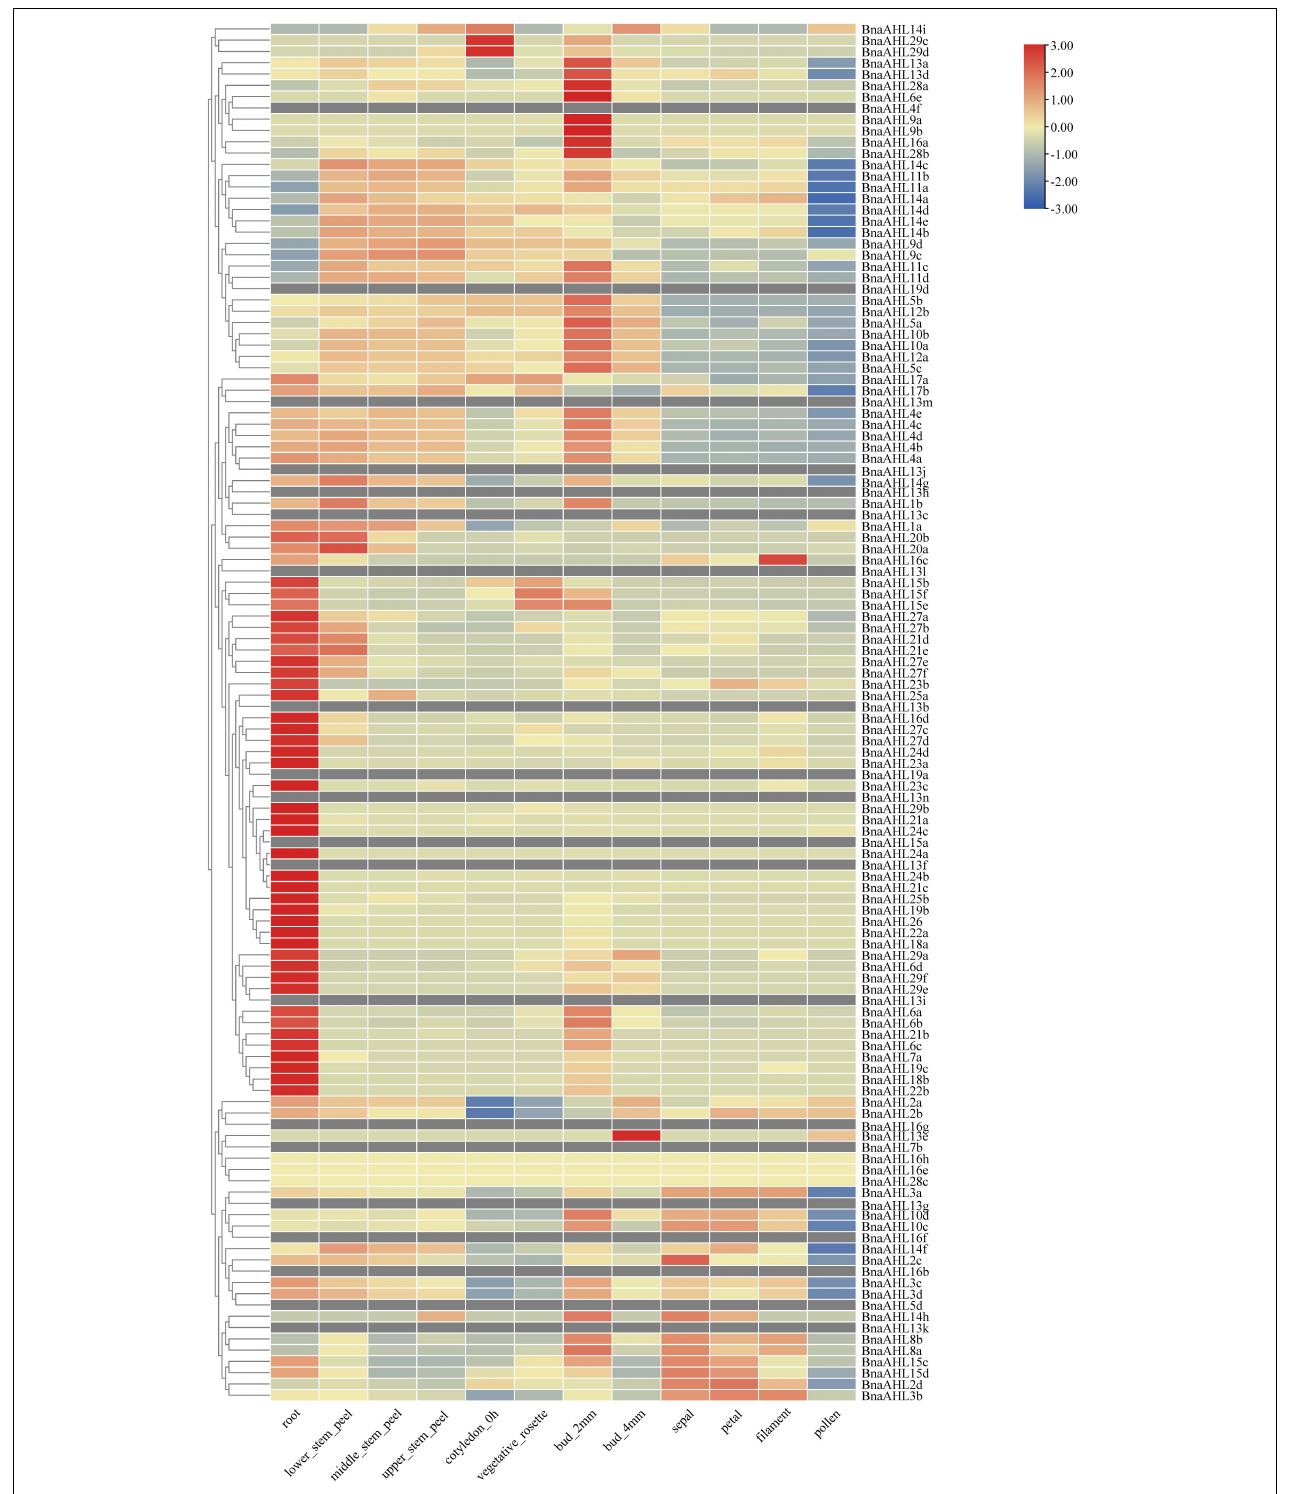
FIGURE 7 | Expression patterns of BnaAHLs in different tissues. BnaAHLs are clustered by hierarchical clustering. The FPKM (the reads per kilobase per million mapped reads) method was used to normalize gene expression. The legend label is shown on the right side of the figure. Genes with high expression levels are shown in red, genes with ground expression levels are shown in blue. The gray box indicates that the expression level of the gene has not been found in the database.